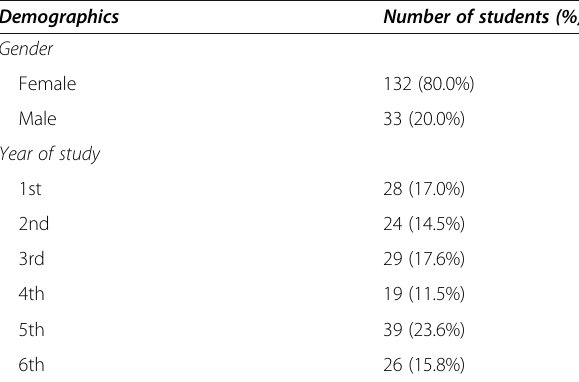
Table 1 Sociodemographic characteristics of 165 surveyed